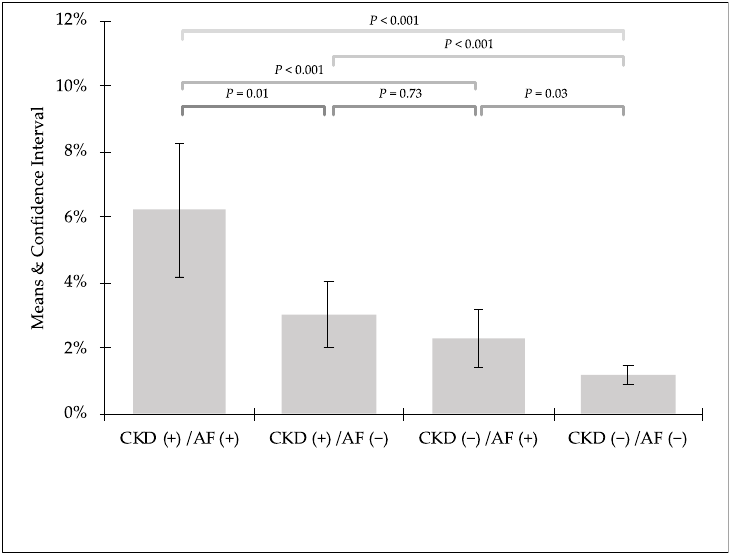
Figure 2. Detailed comparison of prevalence of post-contrast acute kidney injury.